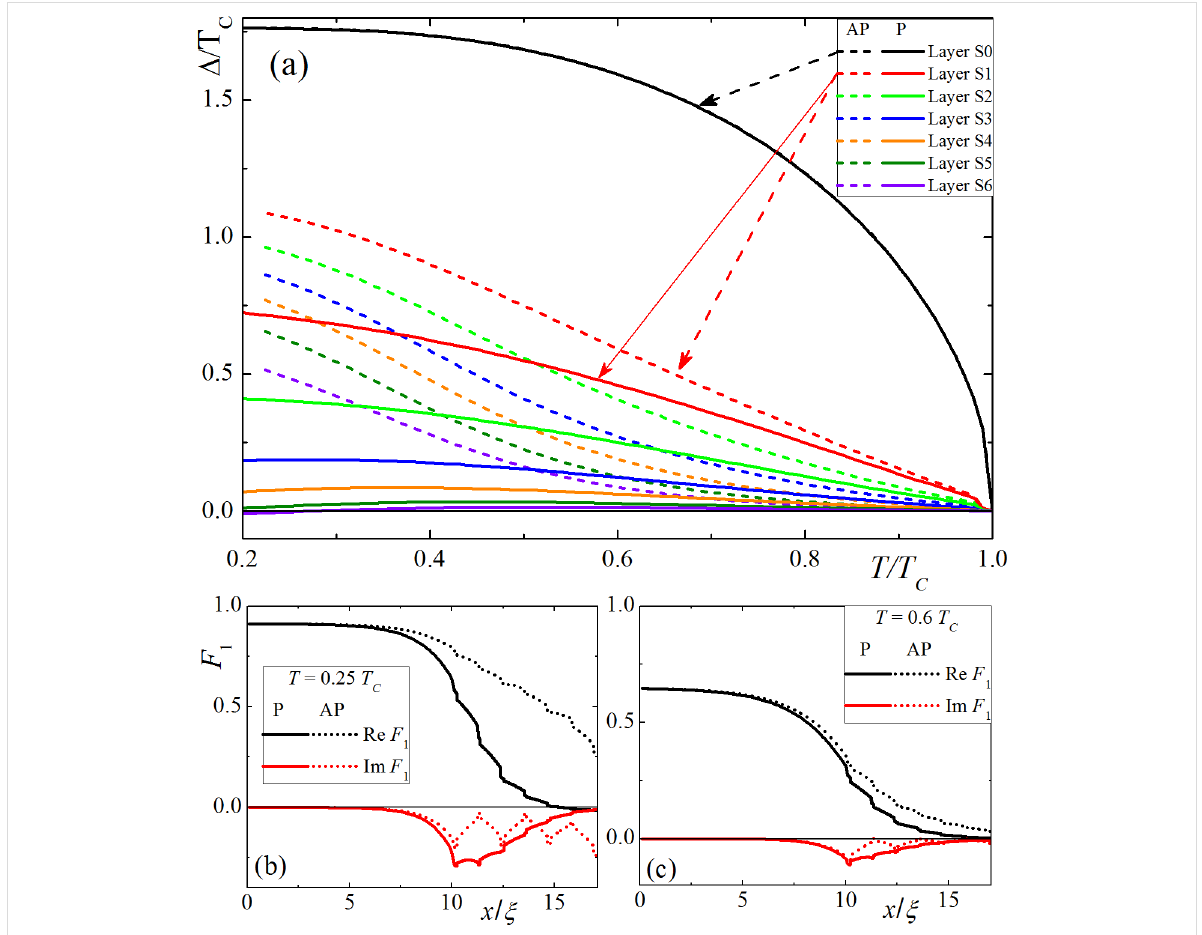
Figure 2: (a) Pair amplitude, Δ , in a S(F1sF2s) x3 F1 structure in different superconducting layers as a function of temperature, T , for parallel (solid lines) and antiparallel (dashed lines) magnetization orientations, considering γ = 1. (b,c) Spatial distributions of the anomalous Green’s function, F 1 ( x ), for parallel (solid lines) and antiparallel (dashed lines) magnetization orientations at different temperature values: T = 0.25 T C (b) and T = 0.6 T C (c)